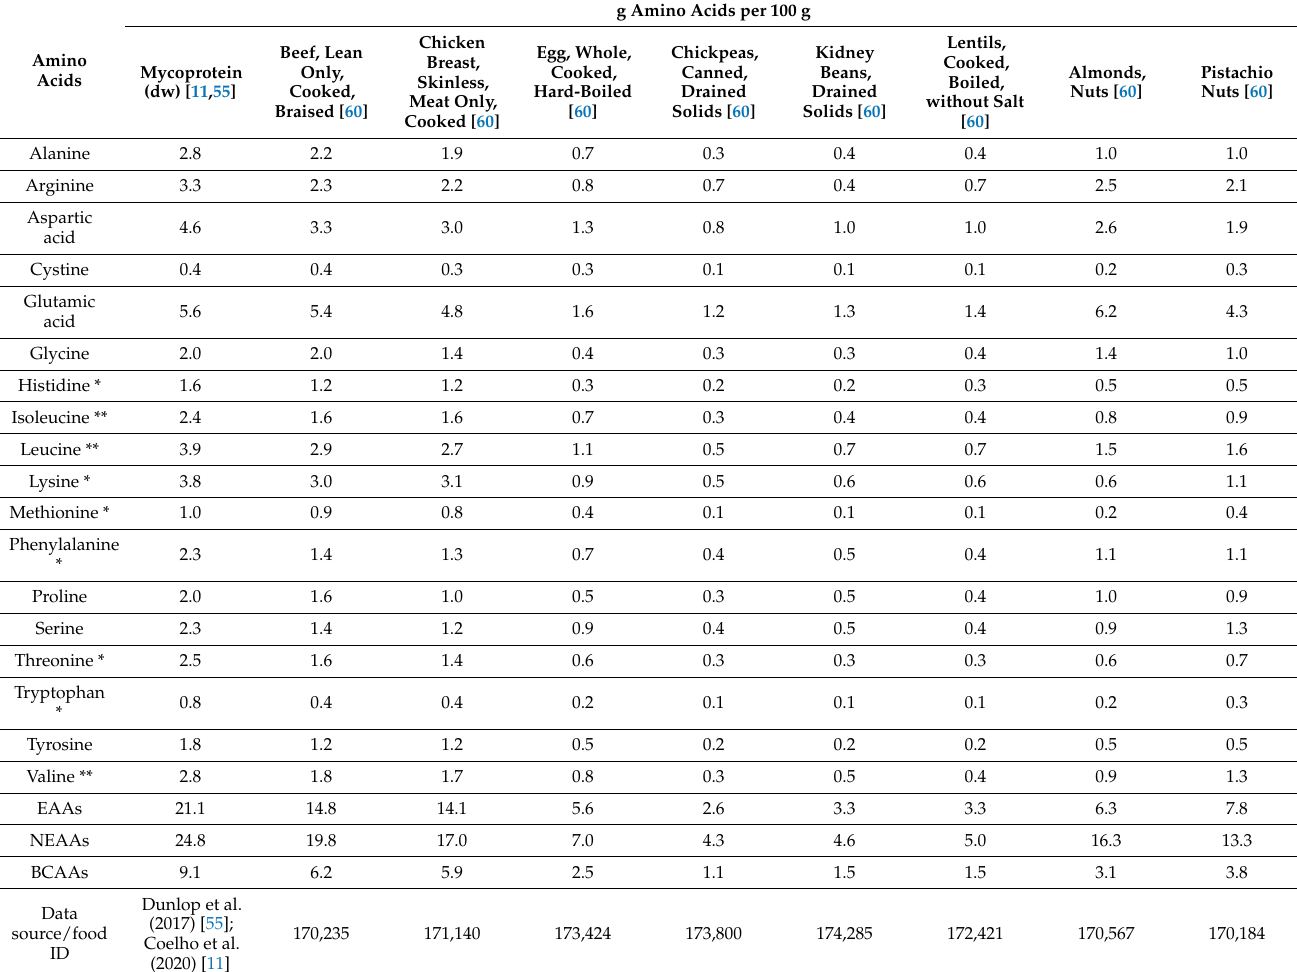
Table 1. Amino Acid Profile of Mycoprotein and other Protein